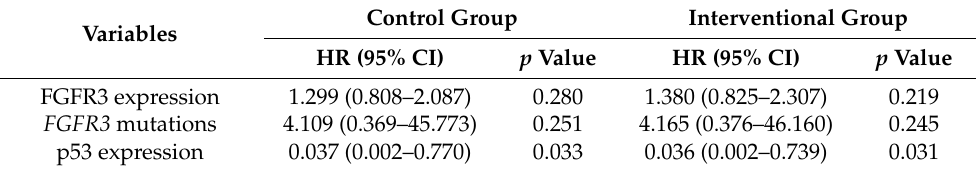
Table 4. Univariate Cox regression models for the association between FGFR3 expression, FGFR3 mutations rate, p53 protein expression, and survival time in control and interventional groups